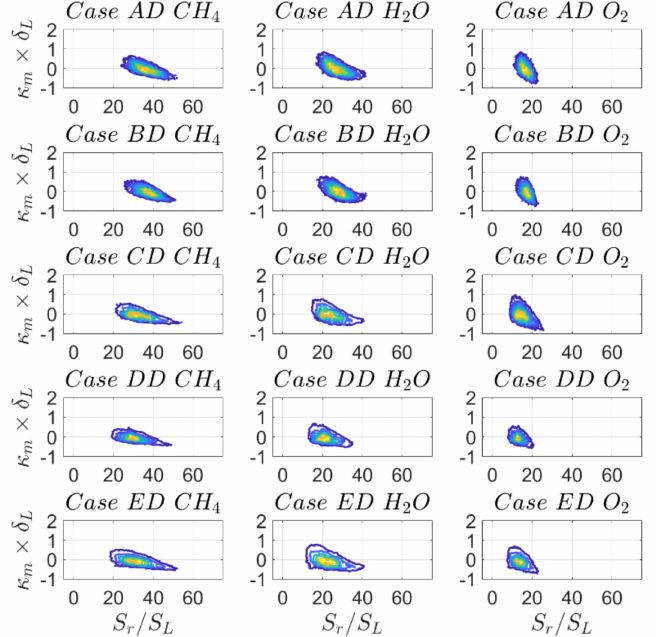
Figure A3. Joint PDF reaction component of displacement speed based on (1st to 3rd column) CH 4 , H 2 O,O 2 and normalised mean curvature κ m × δ L . All results are shown for c = 0.8 isosurface based on O 2 mass fraction, for top to bottom cases AD–ED.